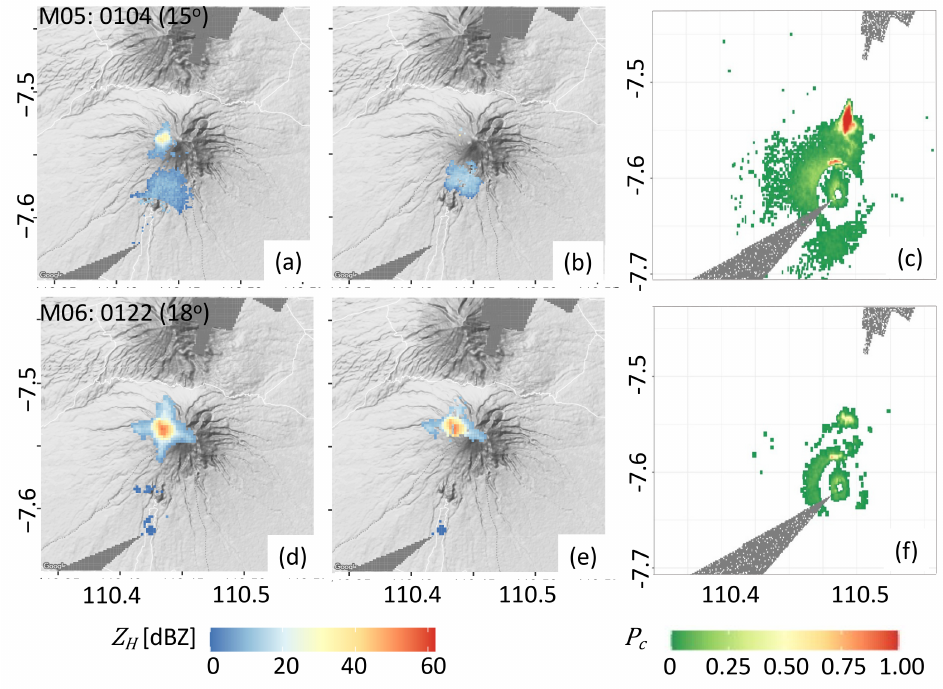
Figure A1. An example of the clutter cancellation results. Data are presented for elevation angles of 15 and 18 ◦ . The cases and time stamps are given in the top left corner. ( a , d ) The observed radar reflectivity intensity factor Z HH , ( b , e ) the filtered Z H after applying the clutter cancellation procedure, and ( c , f ) the frequency clutter map Pc for the given elevation angles. In each image, the x -axis is longitude and y -axis is